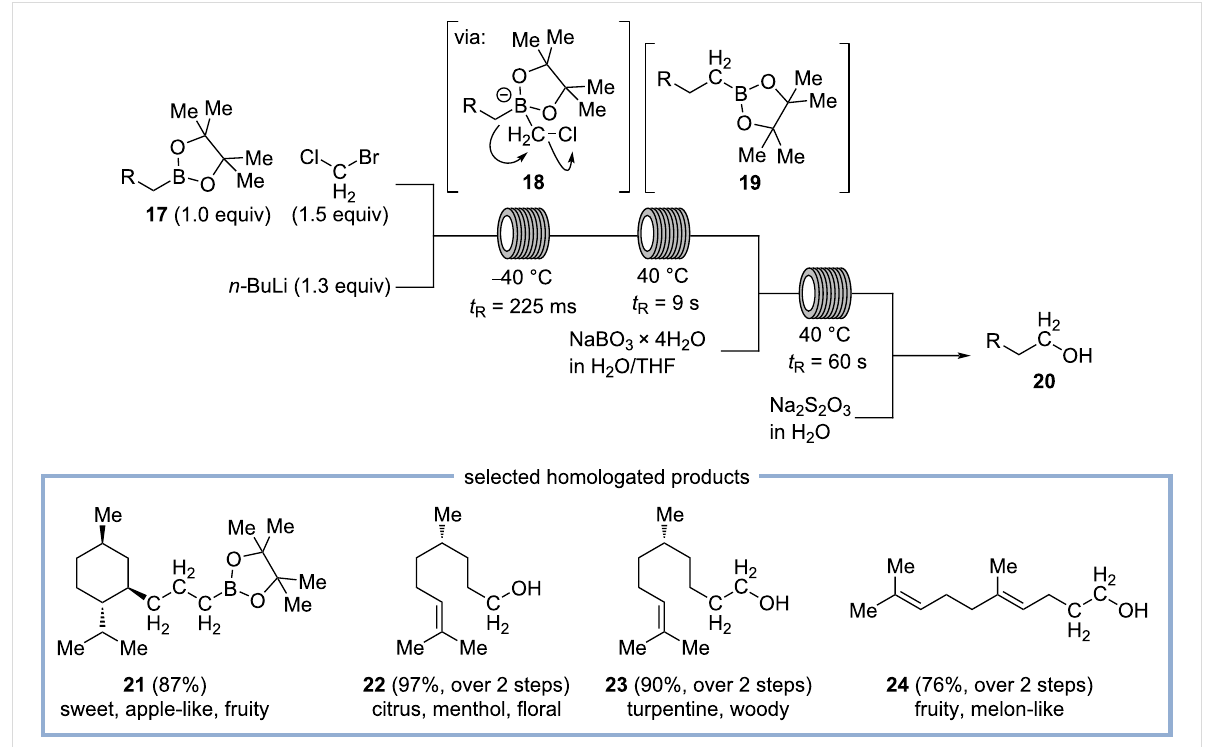
Scheme 5: Synthesis of homologated alcohols 20 by iterative homologation of terpenyl boronate esters 17 followed by oxidation in